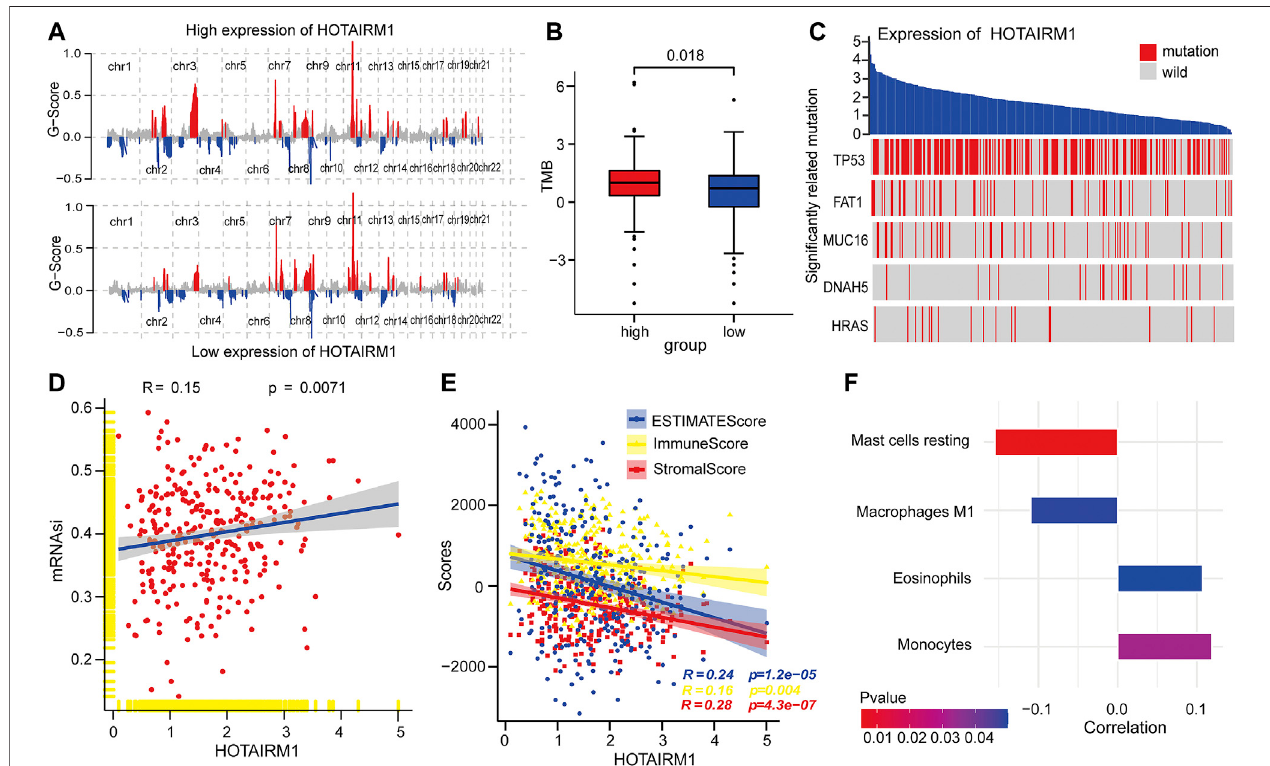
FIGURE 3 | Correlation analyses between HOTAIRM1 and tumorigenesis-relevant variables. (A) The copy number variation of each chromosome in the samples with high-HOTAIRM1 and low-HOTAIRM1 expression of OSCC is shown. The red peaks represent recurring focal ampli fi cation of chromosomes, while the blue areas represent deletions. (B) TMB was higher in OSCC patients with high-HOTAIRM1 expression than in patients with low-HOTAIRM1 expression. (C) Relevance between HOTAIRM1expression andstatusofgenemutationsandthe fi vemostcorrelatedgenes. (D) TherelativeassociationbetweenthestemnessindexandHOTAIRM1 expression in OSCC. (E) The correlation analysis between HOTAIRM1 expression and cellular components related to the tumor microenvironment in OSCC, as assessed by the stromal score, immune score, and ESTIMATE score. (F) Several immune-in fi ltrating cells markedly associated with HOTAIRM1